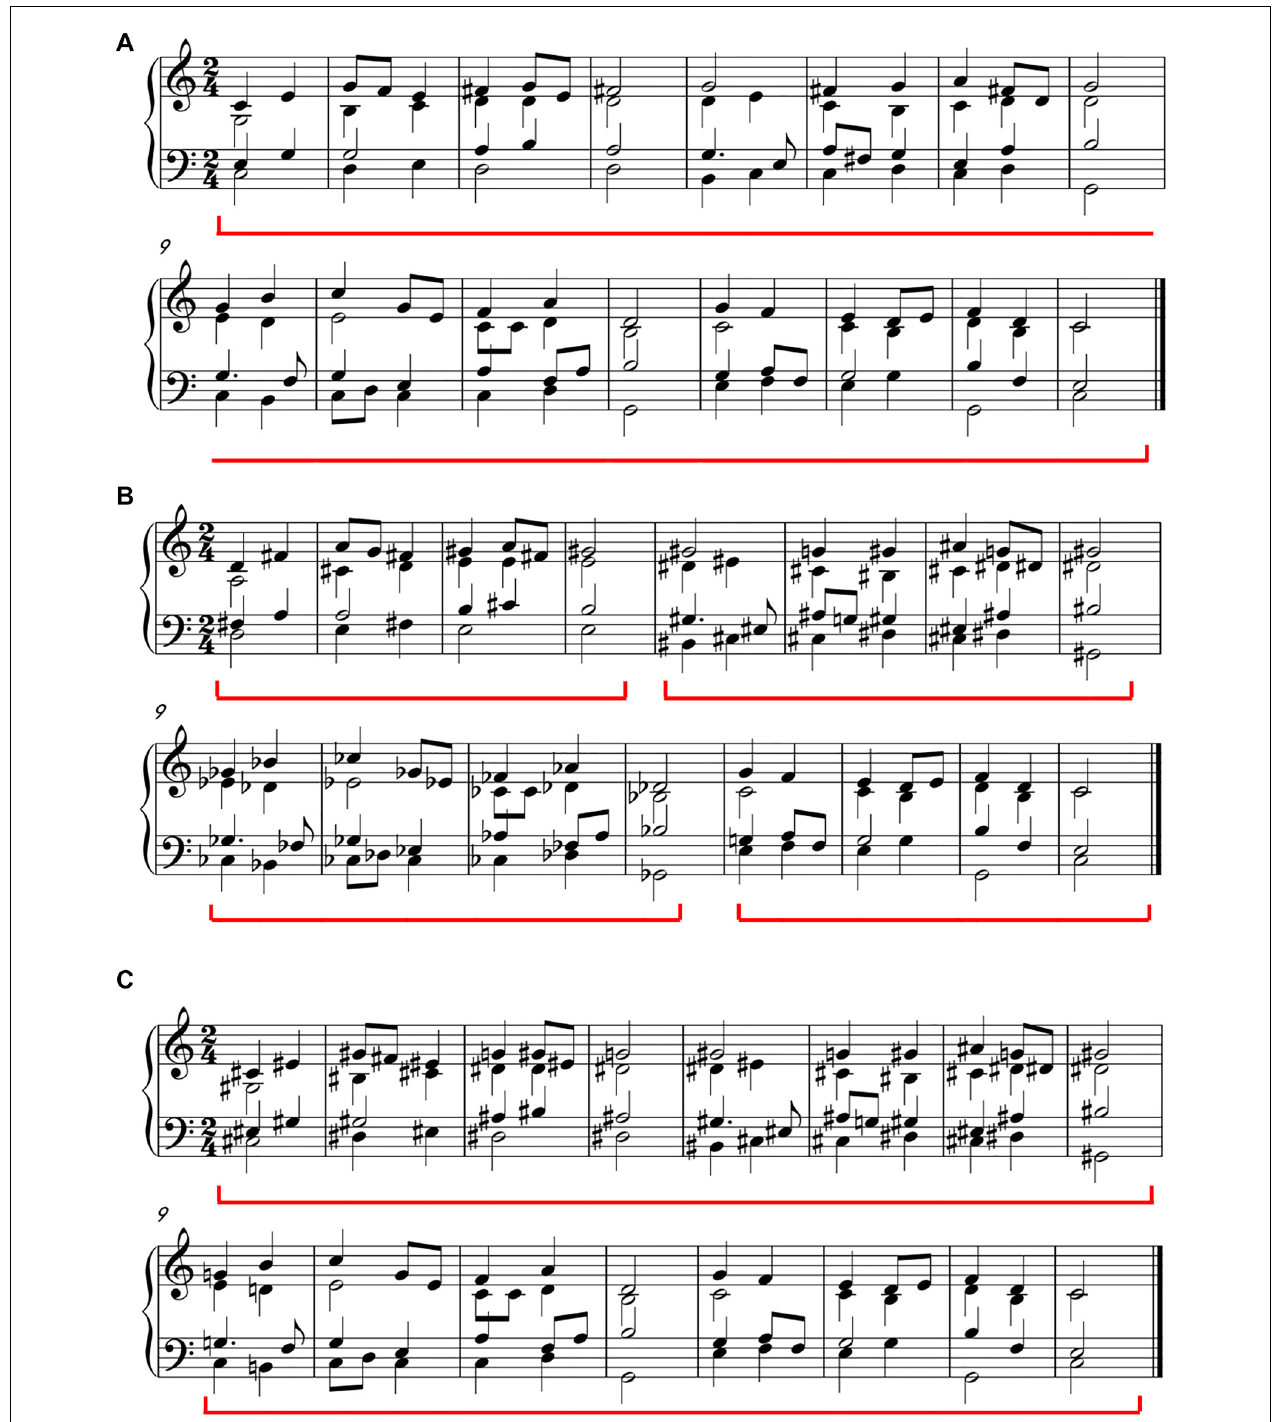
FIGURE 1 | Samples of the musical sequences used in the study. Condition 1: a sequence with a well-formed hierarchical structure (A) . Condition 2: a sequence with phrase violations (B) . Condition 3: a sequence with a period violation (C) .